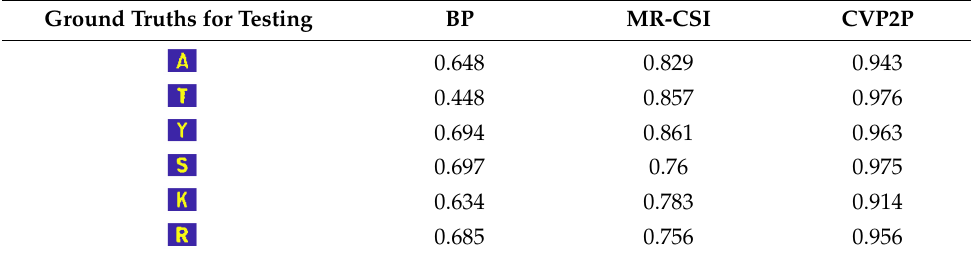
Figure 4. Example 2: Reconstructed contrast of letter-shaped objects are obtained by different imaging algorithms. The final reconstruction results are presented in the second, third, and fourth rows, respectively. The ground truths are presented in the first row. Table 3. CC results for the reconstructions in Figure 4.